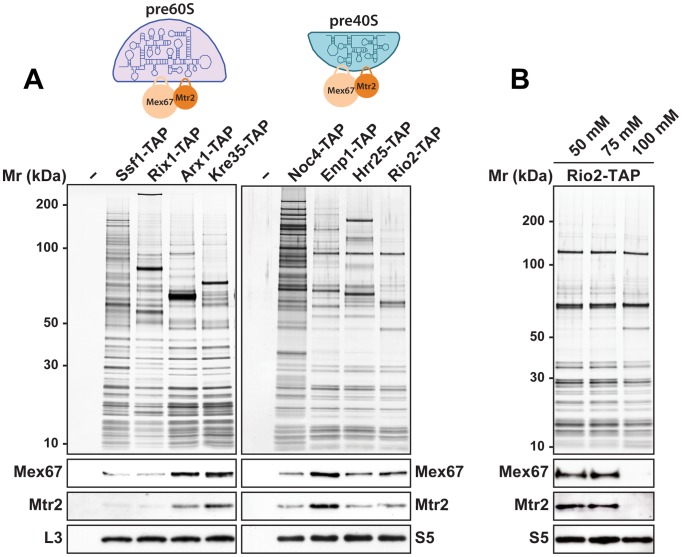
Mex67-Mtr2 co-enriches with pre40S subunits in a salt-sensitive manner.(A) Mex67-Mtr2 co-enrich with late pre60S subunits (left panel) and pre40S subunits (right panel). Tandem affinity purification (TAP) of pre60S subunits was performed via the indicated TAP-tagged bait proteins. (B) Association of Mex67-Mtr2 with pre40S subunits is salt sensitive. Rio2-TAP was performed using lysis buffers with different NaCl concentrations as indicated. (A and B) The calmodulin-sepharose eluates were analysed on NuPAGE 4–12% gradient gels followed by silver staining. Western blotting was performed using antibodies against Mex67 and Mtr2. The large subunit ribosomal protein L3 and the small subunit ribosomal protein S5 served as loading controls, respectively.